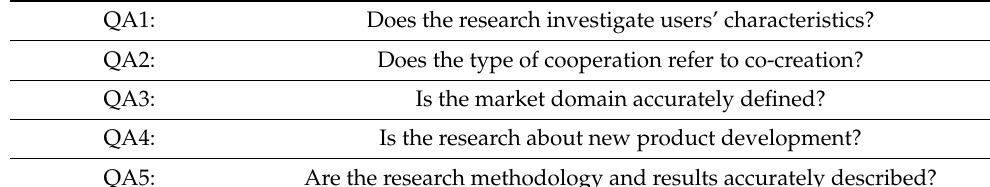
Table 2. List of the quality assessment criteria.